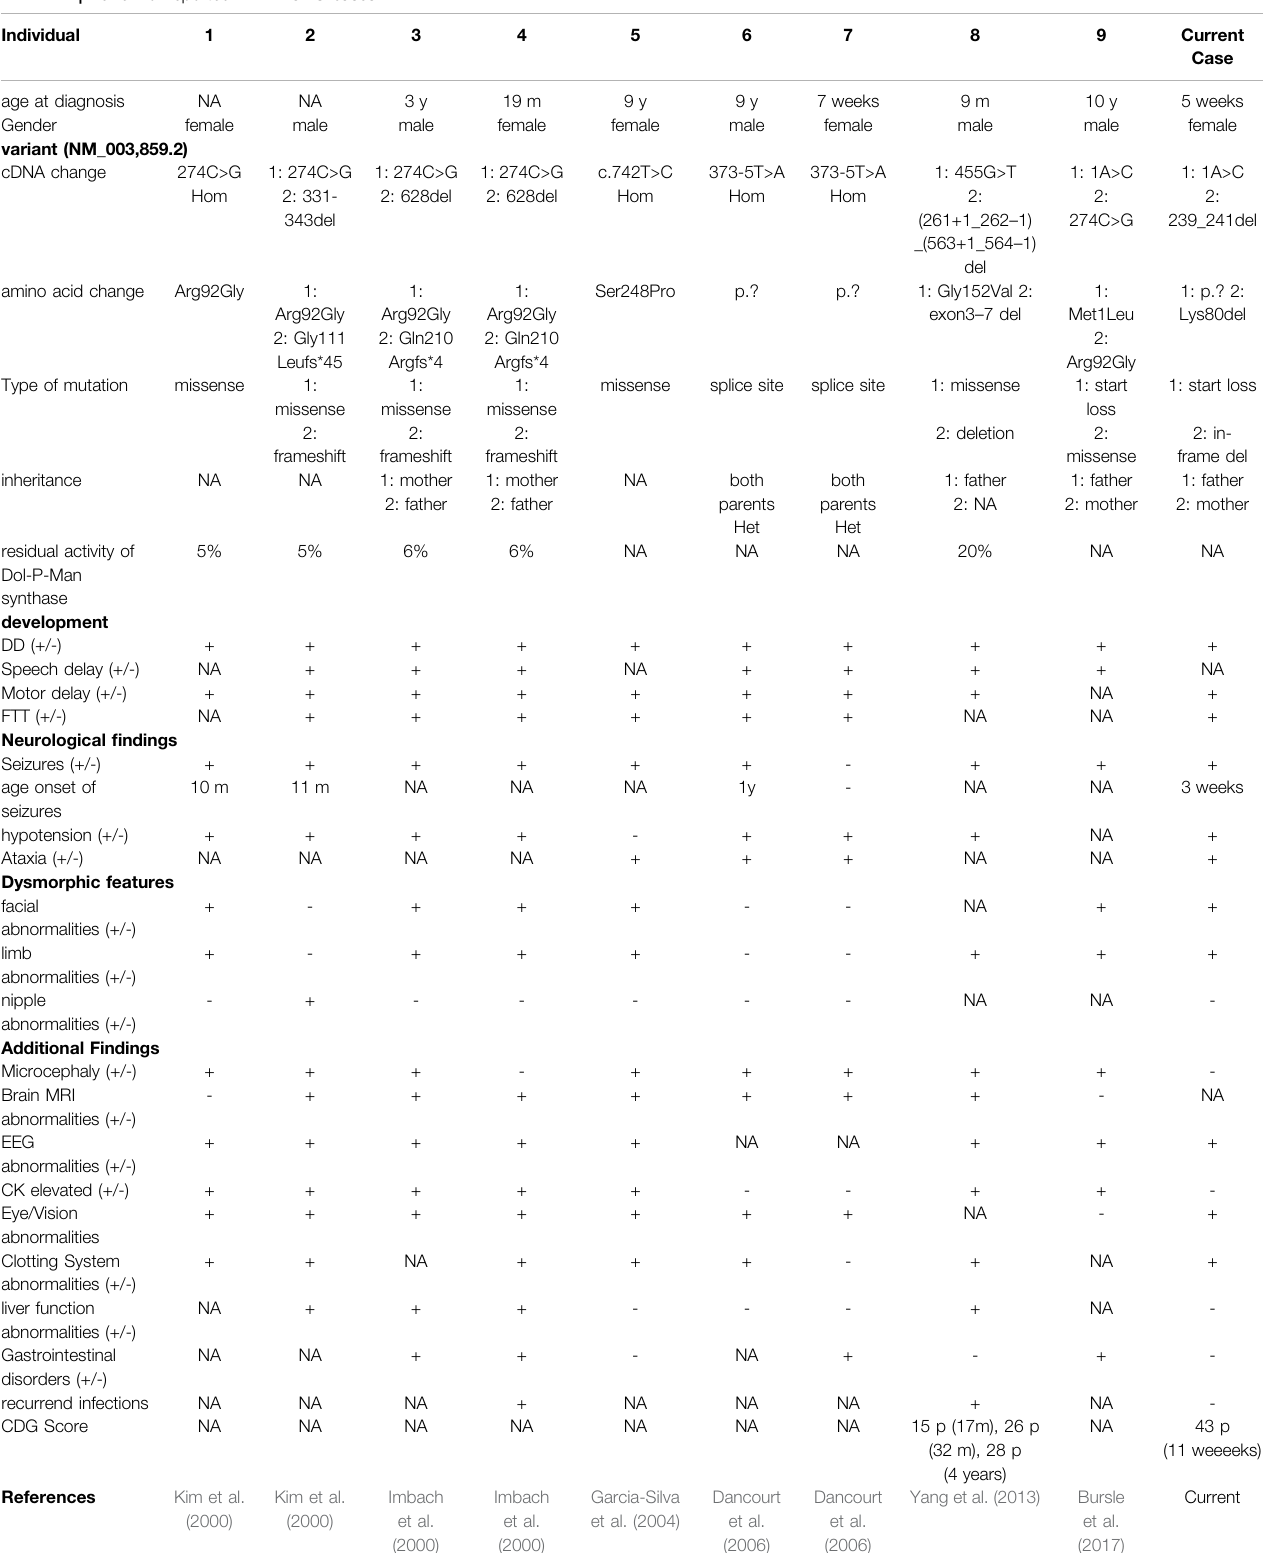
TABLE 1 | Review of reported DPM1-CDG